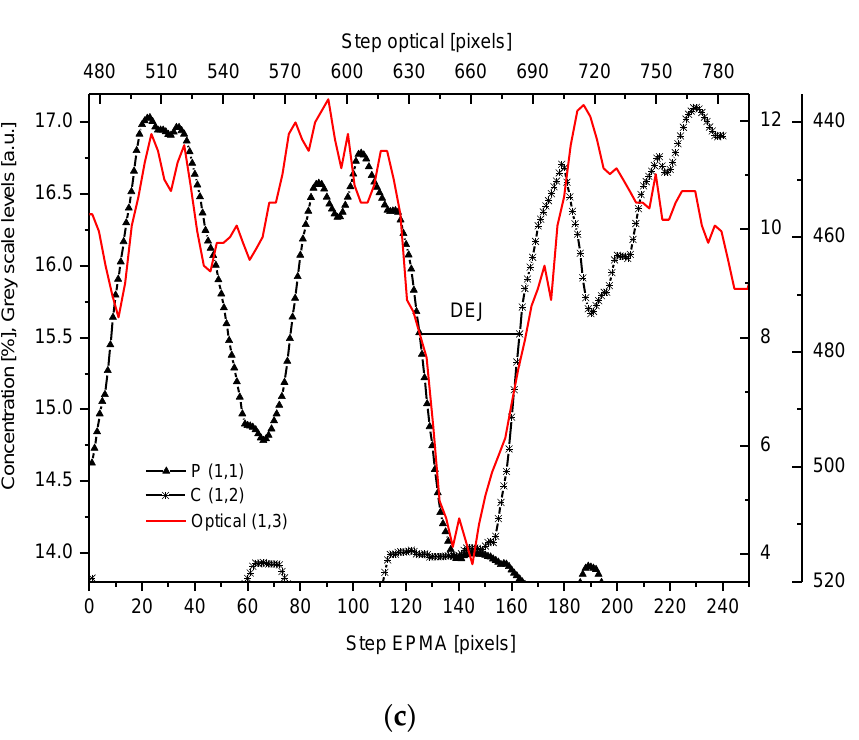
Figure 1. ( a ) Results of EPMA measurements along the DEJ zone. The direction is from the enamel (left) towards the dentin and always the same direction is preserved in the next figures (where relevant), and the length is equal to 250 µm. 1 step = 1 µm. ( b ) Sequence of C and Mg variability, in majority cases inversely directed. ( c ) Outline of the DEJ space with optical signal and in parallel by two spectral signals of P and C. On multiscale figures the numerical markers were introduced where the first number denotes x-axes, calculated in the system down-up and the second one y-axes, calculated from left to right side of the figure.